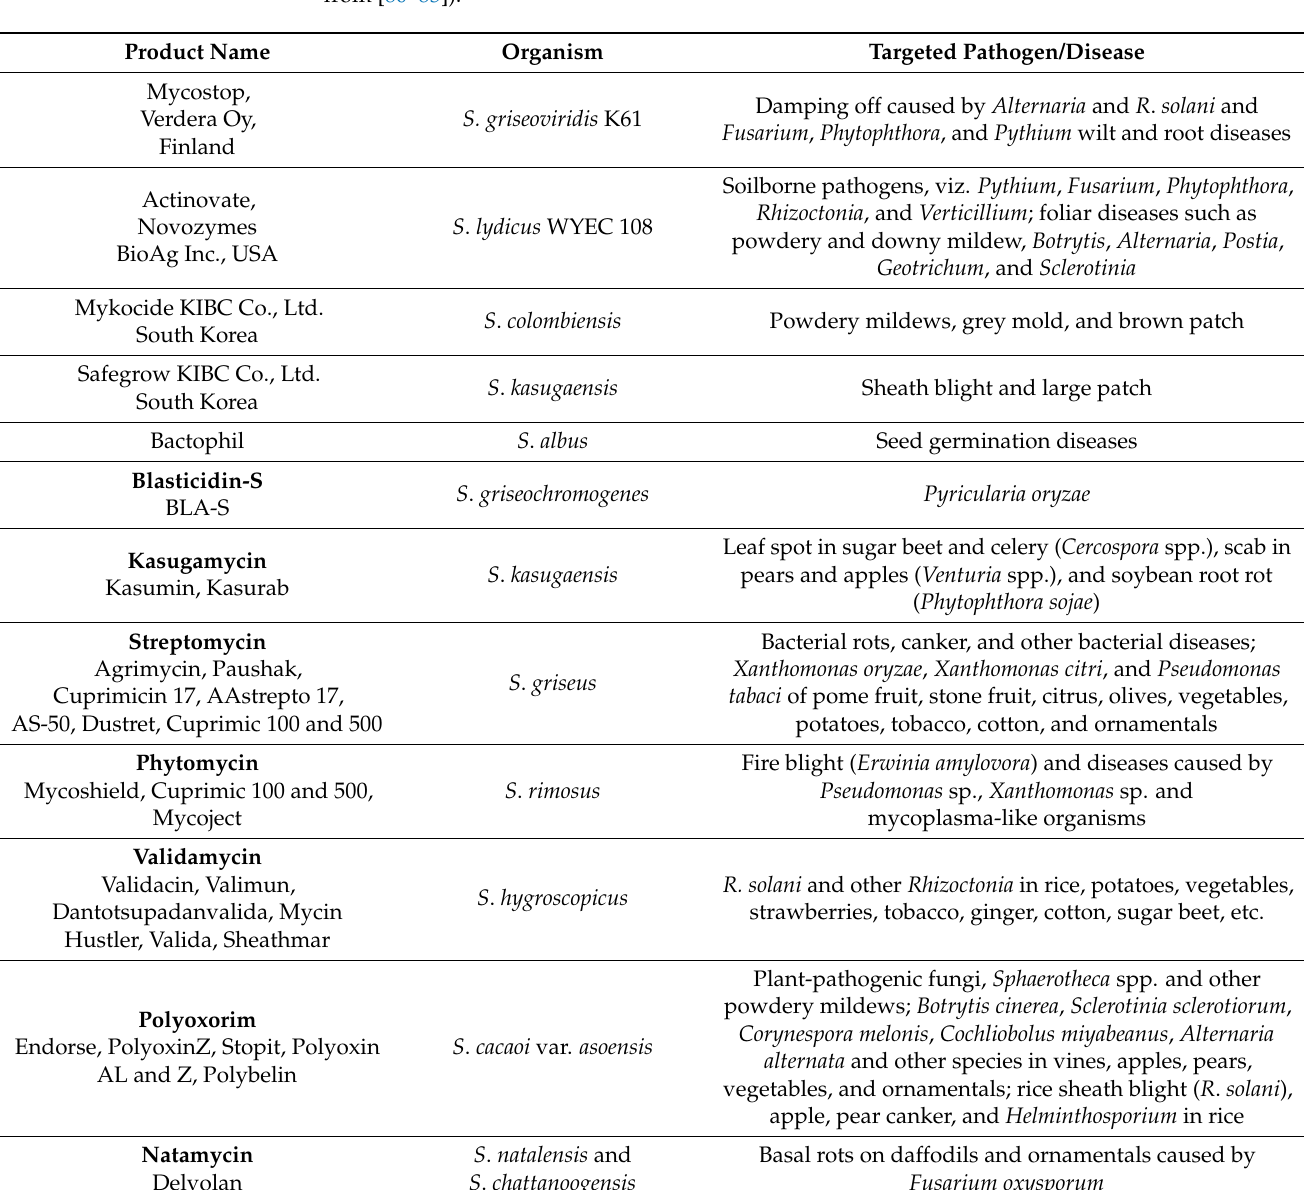
Table 2. List of Streptomyces spp.-based products and active substances derived from them registered as commercial products to control of plant pathogens (data collected and modified into a table from